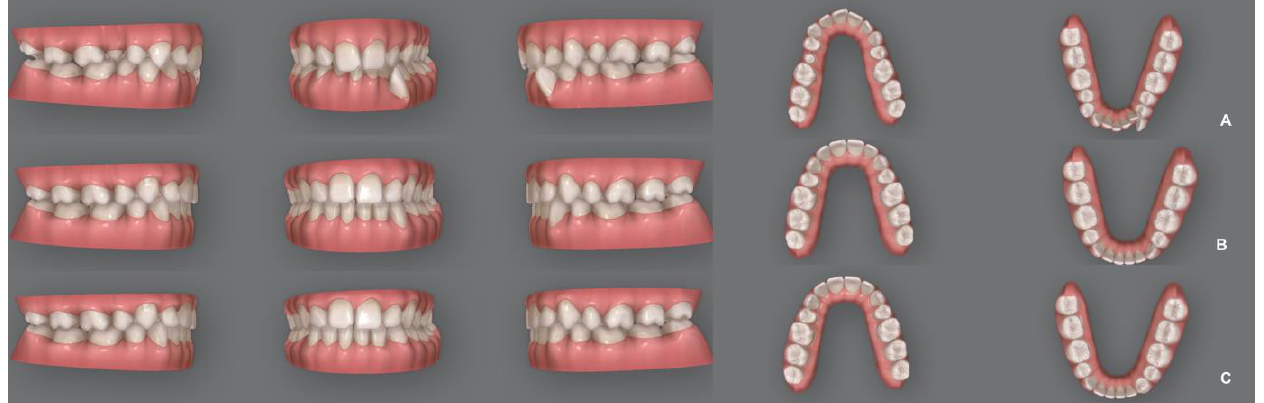
Figure 10. Example of diagnostic setup with Invisalign system (Align Technology, San Jose, CA, USA) planned to decide the best treatment option. ( A ), Pre-treatment condition; ( B ), first setup with extraction of lower right first premolar; ( C ), second setup with extraction of lower right canine.